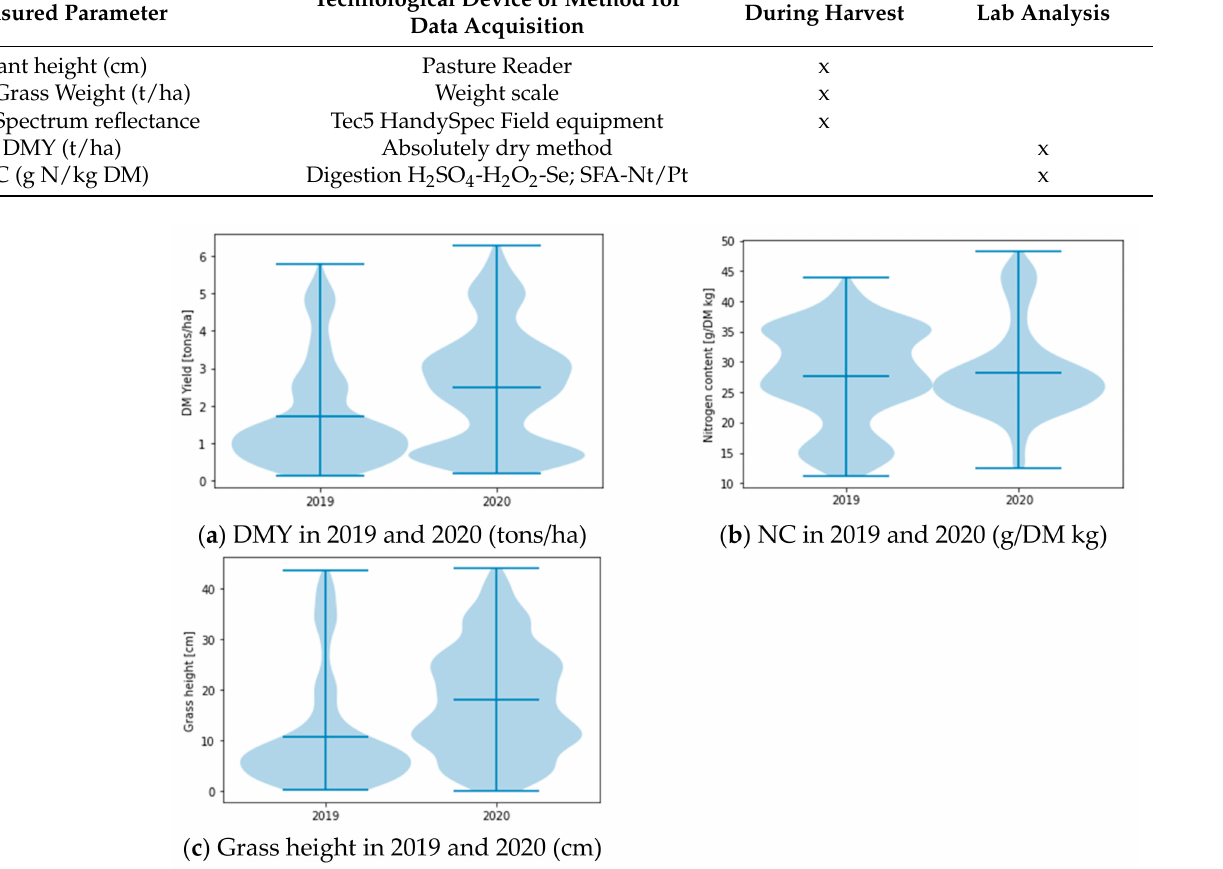
Figure 3. Histograms of measured data during harvest in 2019 and 2020: ( a ) DMY in 2019 and 2020; ( b ) NC in 2019 and 2020; ( c ) Grass height in 2019 and 2020. The width of the graph represents the number of samples, while Y-axis corresponds to the measured variables. The measurement of DMY and NC were conducted by using the absolute dry method and the “digestion H 2 SO 4 -H 2 O 2 -Se; SFA-Nt/Pt” method, respectively. In addition, grass height was measured by ultrasonic